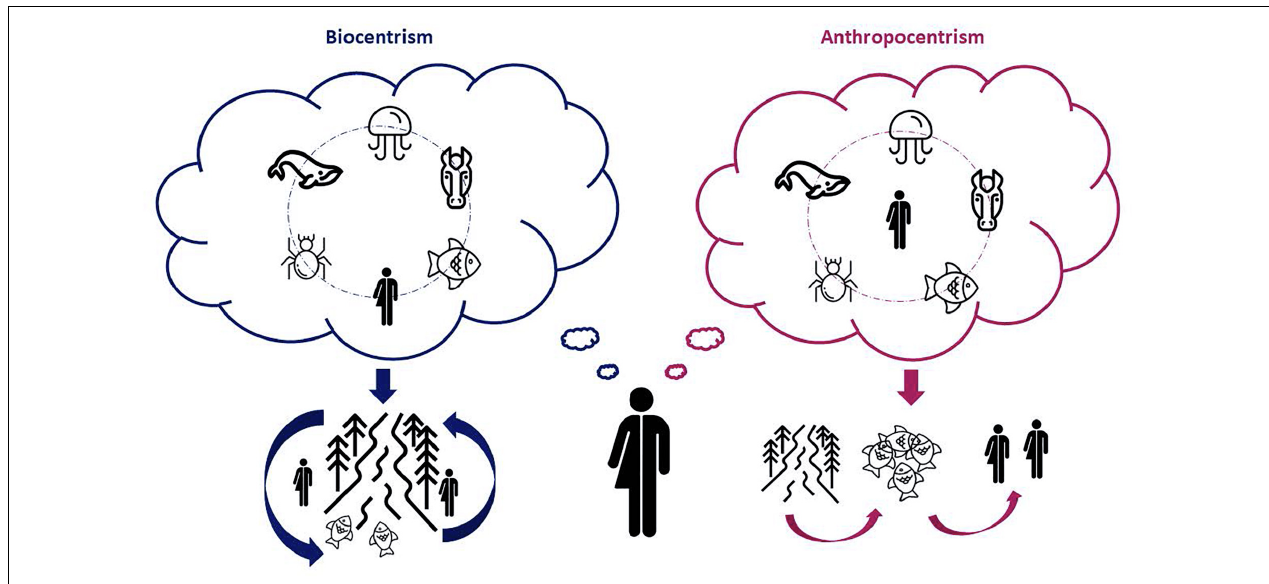
FIGURE 2 | Differences in the biocentric and anthropocentric ethic as shown in the internal narrative and resulting